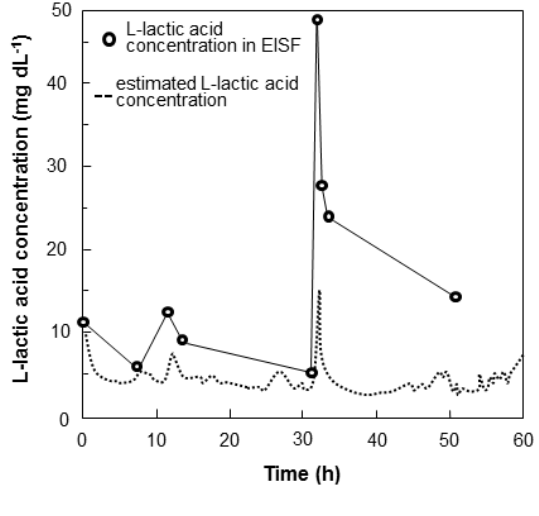
Figure 9. Change in the estimated L -lactic acid concentration based on the wireless monitoring system. The L -lactic acid concentrations in the EISF at 0 min, plotted as black circles, were used for the one-point calibration